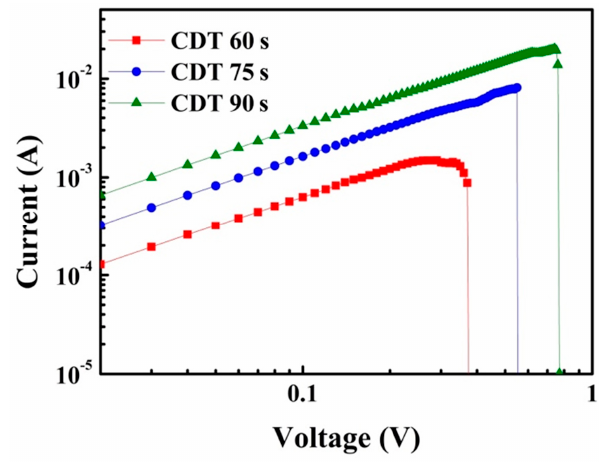
Figure 5. I–V curves in logarithmic scale for the ReRAM devices in the LRS.